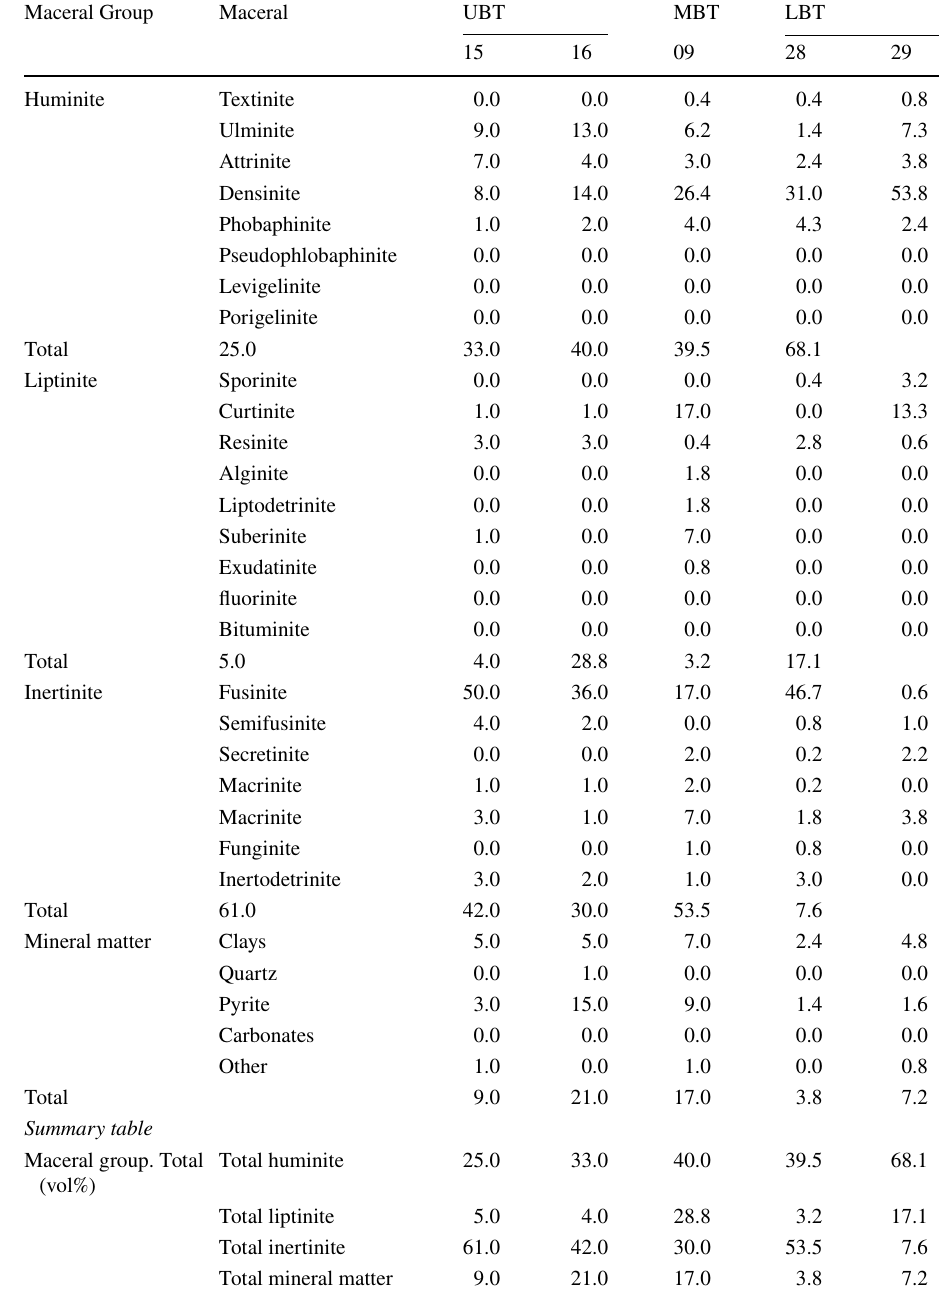
Maceral Group Maceral